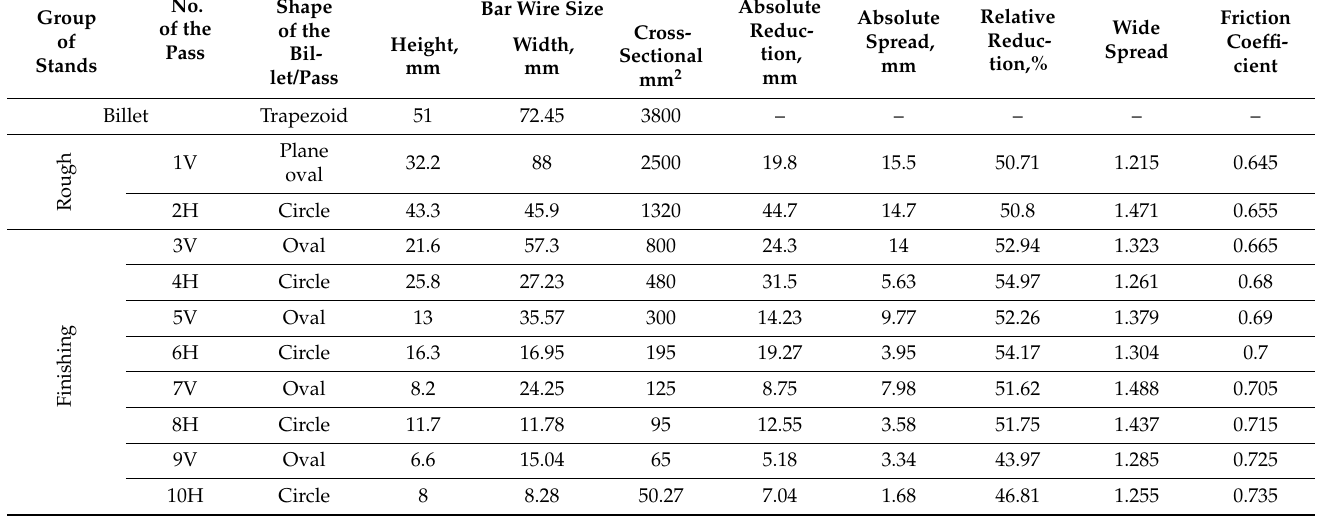
Table 2. Chemical composition of T2 copper (mass fraction,